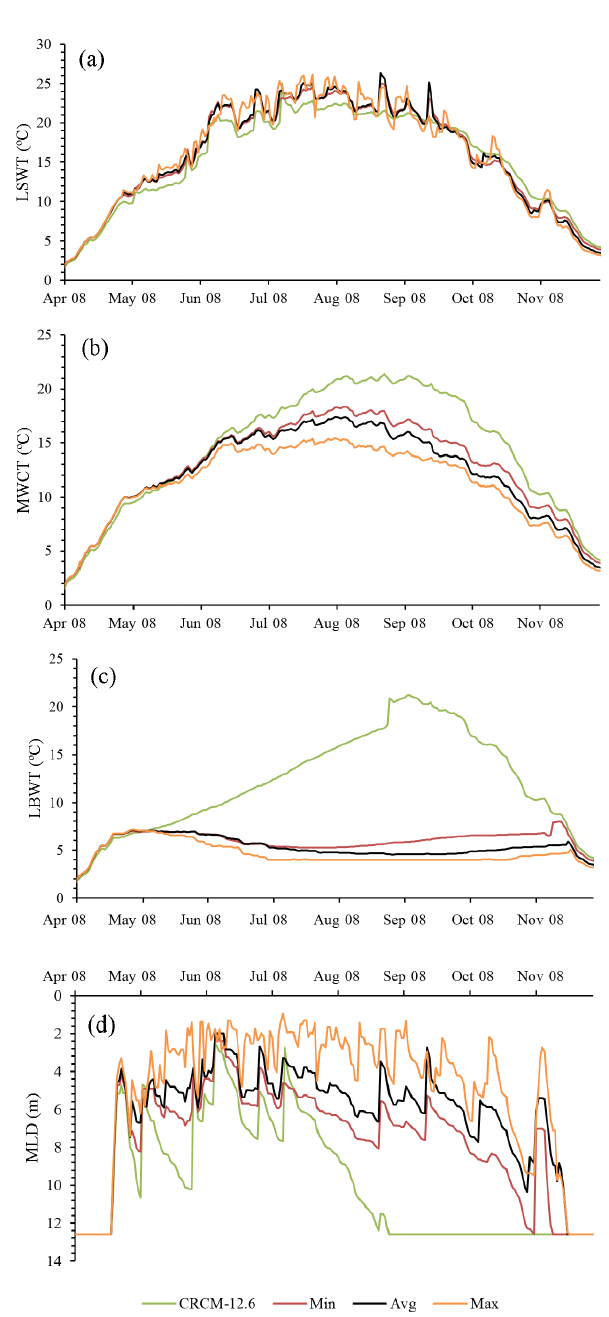
Figure 6. LSWT (a) , MWCT (b) , LBWT (c) and MLD (d) simula- tion results in 2008 for CRCM-12.6 ( K d = 0 . 2m − 1 ) simulation and the lowest (Min, K d = 0 . 58m − 1 ), average (Avg, K d = 0 . 90m − 1 ), and highest (Max, K d = 3 . 54m − 1 ) K d values are